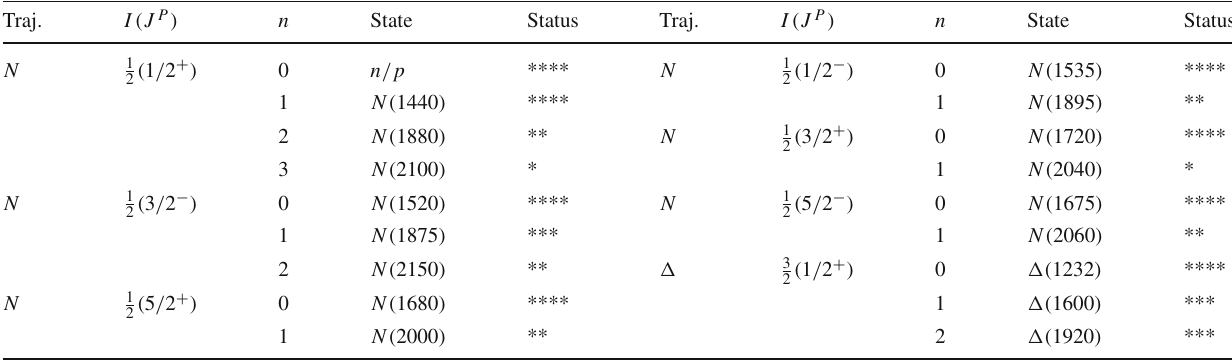
Table 19 The baryon states used in the ( n , M 2 ) trajectory fits and their assignments. The fourth column indicates the status given to each state by the PDG, ranging from * for unconfirmed states to **** for those whose properties are certain Traj.